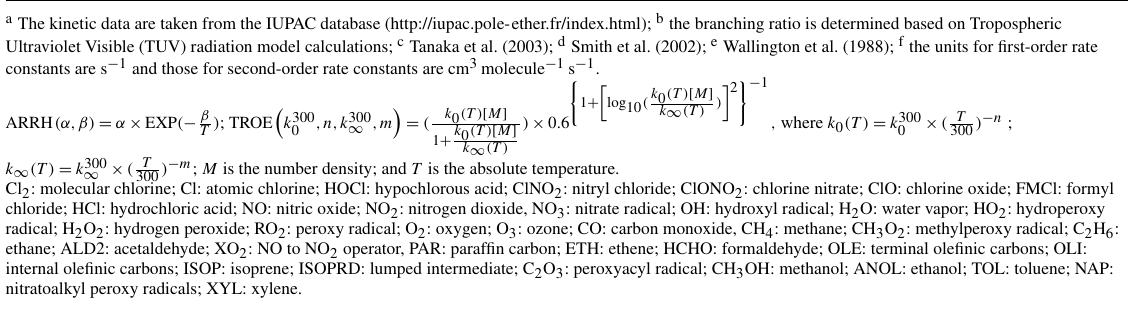
a The kinetic data are taken from the IUPAC database (http://iupac.pole-ether.fr/index.html); b the branching ratio is determined based on Tropospheric Ultraviolet Visible (TUV) radiation model calculations; c Tanaka et al. (2003); d Smith et al. (2002); e Wallington et al. (1988); f the units for first-order rate constants are s − 1 and those for second-order rate constants are cm 3 molecule − 1 s − 1